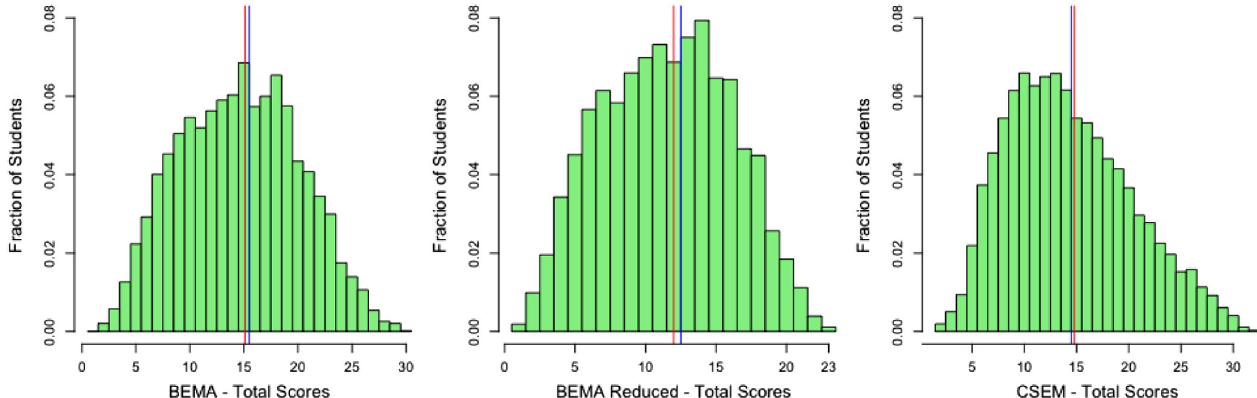
FIG. 1. Histograms of the fraction of the total number of students for all possible total scores. For the BEMA there were no scores below 3 and for the CSEM there were no scores below 2. The vertical red line indicates the sample mean and blue is for